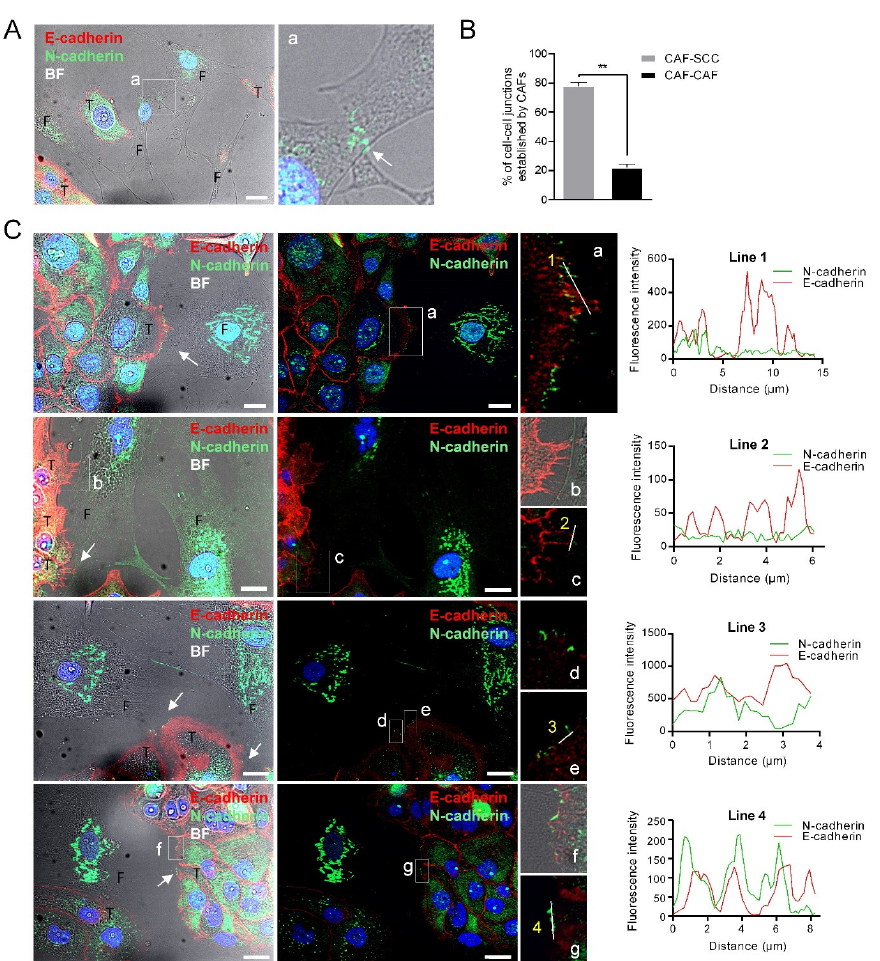
Figure 4. N-cadherin does not co-localize with E-cadherin at the membrane contacts established between CAFs and E+ SCC cells. Representative bright-field and immunofluorescences of UT-SCC-42B plus CAF3 co-cultures with anti E-cadherin (red) and N-cadherin (green) antibodies. Panel ( A ) shows the interaction between two CAFs; a higher magnification of the region (a) denoted by a white square is shown at the right picture to highlight the N+-cadherin mediated interaction. Panel ( B ) shows the percentage of cell–cell junctions (CAF-SCC+ or CAF-CAF) established by CAFs (376 total contacts counted in 3 independent experiments). Panel ( C ) shows four representative examples of the interactions between CAFs and SCC cells. Higher magnifications of the cell-to-cell contacts are shown in the far-right images (a–g). White arrows point to cell-to-cell contacts. Graphics show the fluorescence intensity profiles of the regions of interest indicated with white lines in the fluorescence pictures. T, tumor cell; F, CAF3. Scale bars: 20 μ m.